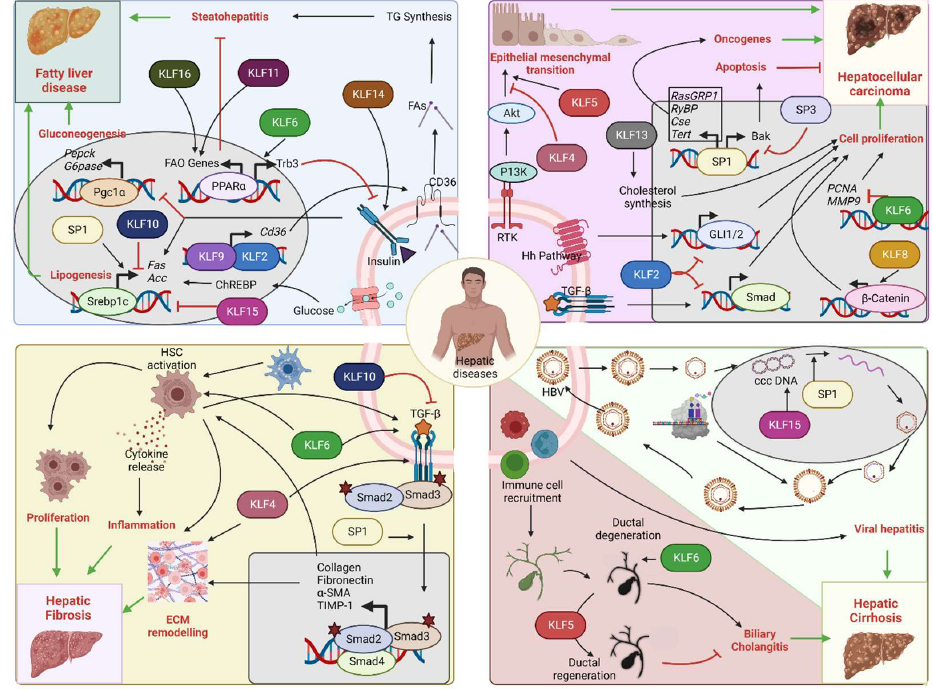
Figure 4. Role of SP/KLF transcription factors in hepatic diseases: Upper left corner: Insulin re- sistance/NAFLD—Insulin signaling promotes SREBF-1-mediated lipogenesis and inhibits PGC-1α- mediated gluconeogenesis. Impaired insulin signaling leads to fatty liver disease. KLF2 and KLF9 drive Cd36 expression that increases fatty acid uptake and steatohepatitis. KLF11 and KLF16 drive